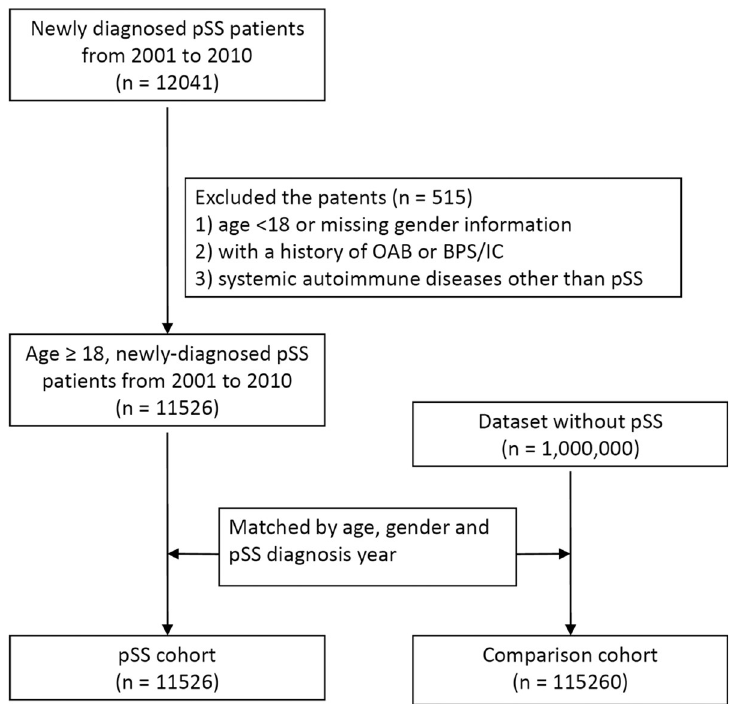
Fig 1. Flow chart for study population selection. pSS: Primary Sjo¨gren syndrome; OAB: overactive bladder; BPS: bladder pain syndrome; IC: interstitial cystitis.